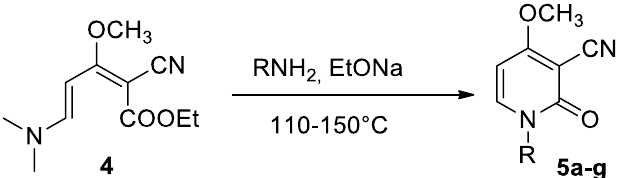
Scheme 5. Synthesis of Ricinine ( 5a ) and N-analogues of Ricinine ( 5b – g ).